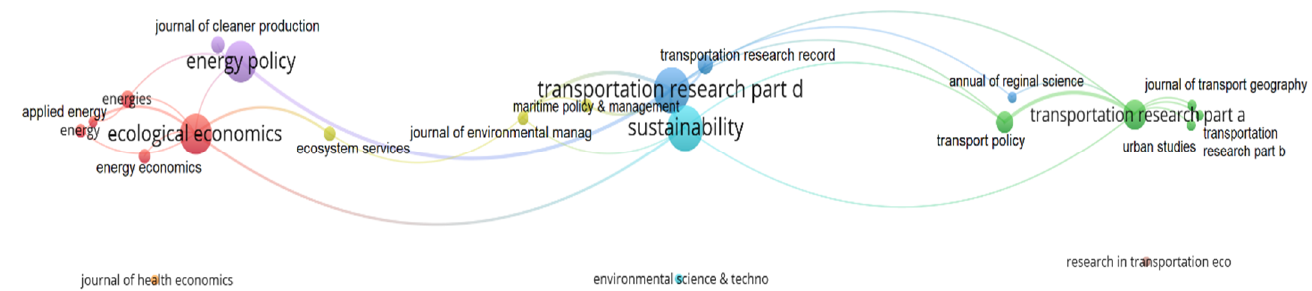
Figure 3. Network of prominent journals for publication in infrastructure externalities research. Table 1. Quantitative summary of journal impacts in infrastructure externalities